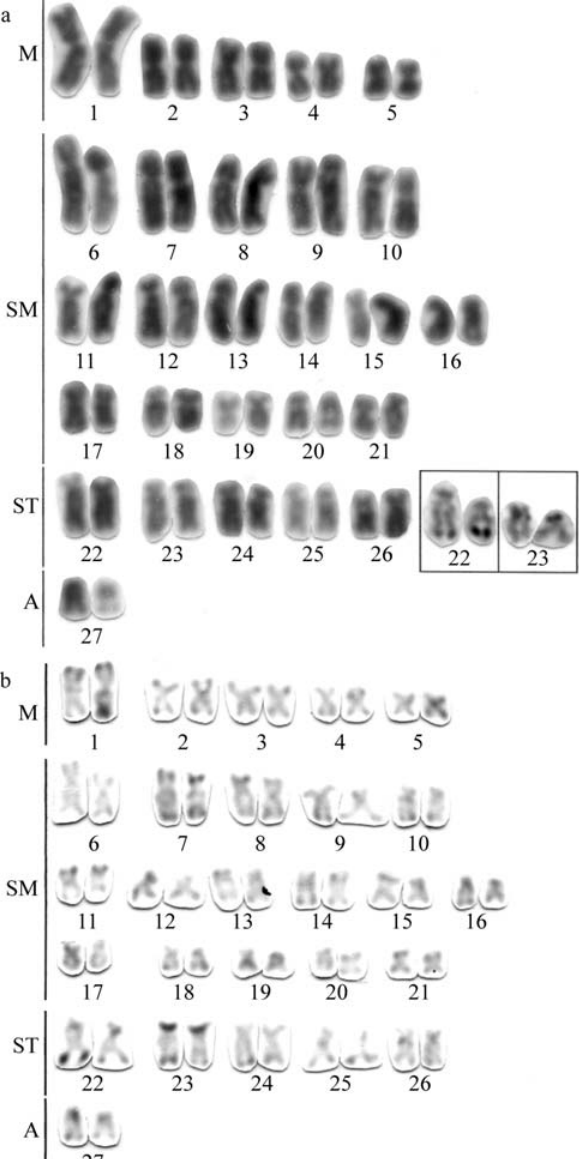
Figure 1 - Karyotype of Cephalosilurus apurensis (2n = 54) after: (a) con- ventional staining and (b) C-banding. In the inset, silver stained chromo- somes showing the terminal Ag-NOR on the short arms of pair 19.